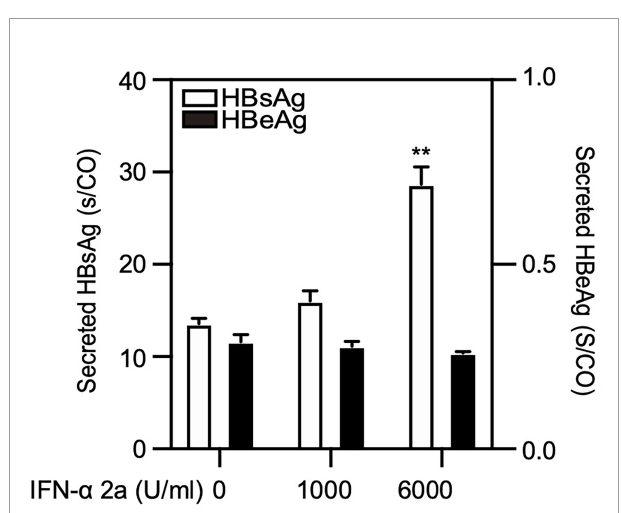
FIGURE 5 | High IFN a -2a concentrations promote the yield of HBsAg in PHHs. PHHs were infected with HBV virions (multiplicity of infection = 30). 4 days post infection, PHHs were treated with IFN a -2a twice (1000 U/ml and 6000 U/ml). After 48 hr, the HBsAg and HBeAg levels in the culture supernatants were harvested and quanti fi ed by chemiluminescent microparticle immunoassay (CMIA). **P <